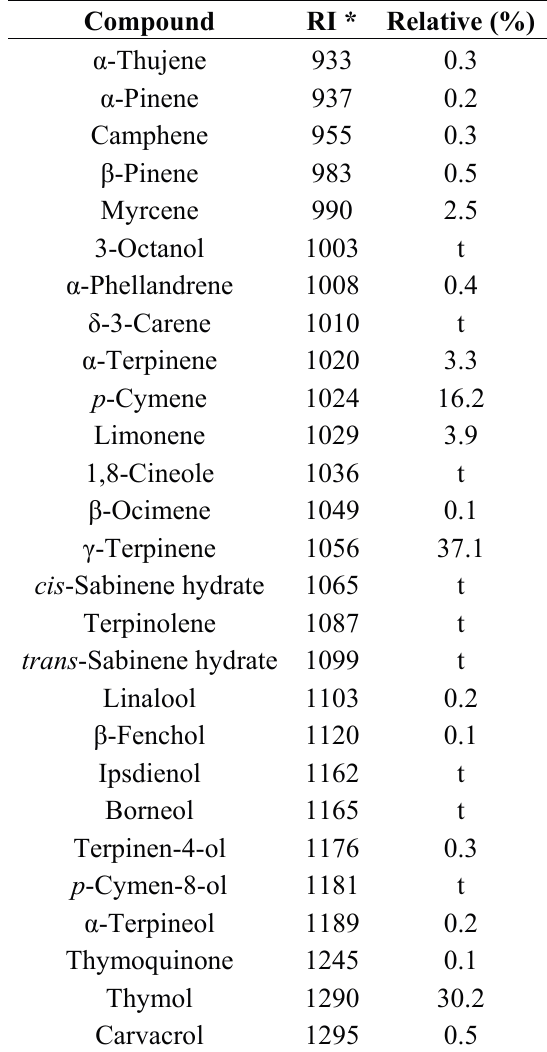
Table 1. Monoterpene and sesquiterpene constituents of Satureja intermedia C.A.Mey essential oil